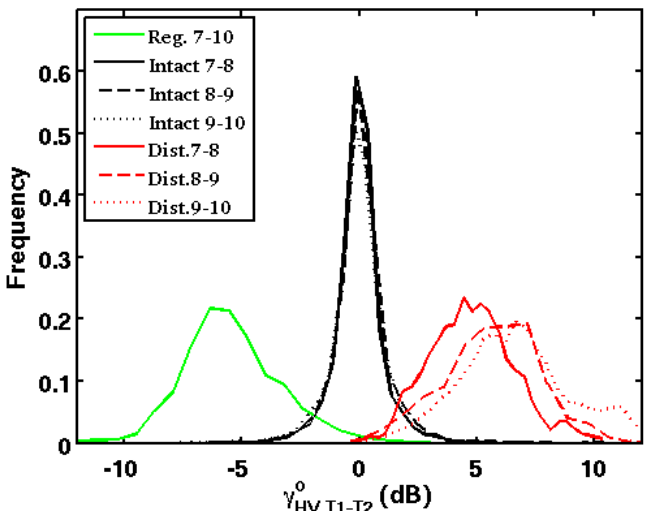
Figure 5. Distributions of the intensity ratio R based on γ HV drawn over intact forest between 2007 and 2008 (Intact. 7–8), 2008 and 2009 (Intact. 8–9) and 2009 and 2010 (Intact. 9–10), disturbed areas between 2007 and 2008 (Dist. 7–8), 2008 and 2009 (Dist. 8–9) and 2009 and 2010 (Dist. 9–10) and regrowth areas between 2007 and 2010 (Reg. 7–10). R based on γ HV is a reliable indicator of forest disturbance and regrowth, even during the wet